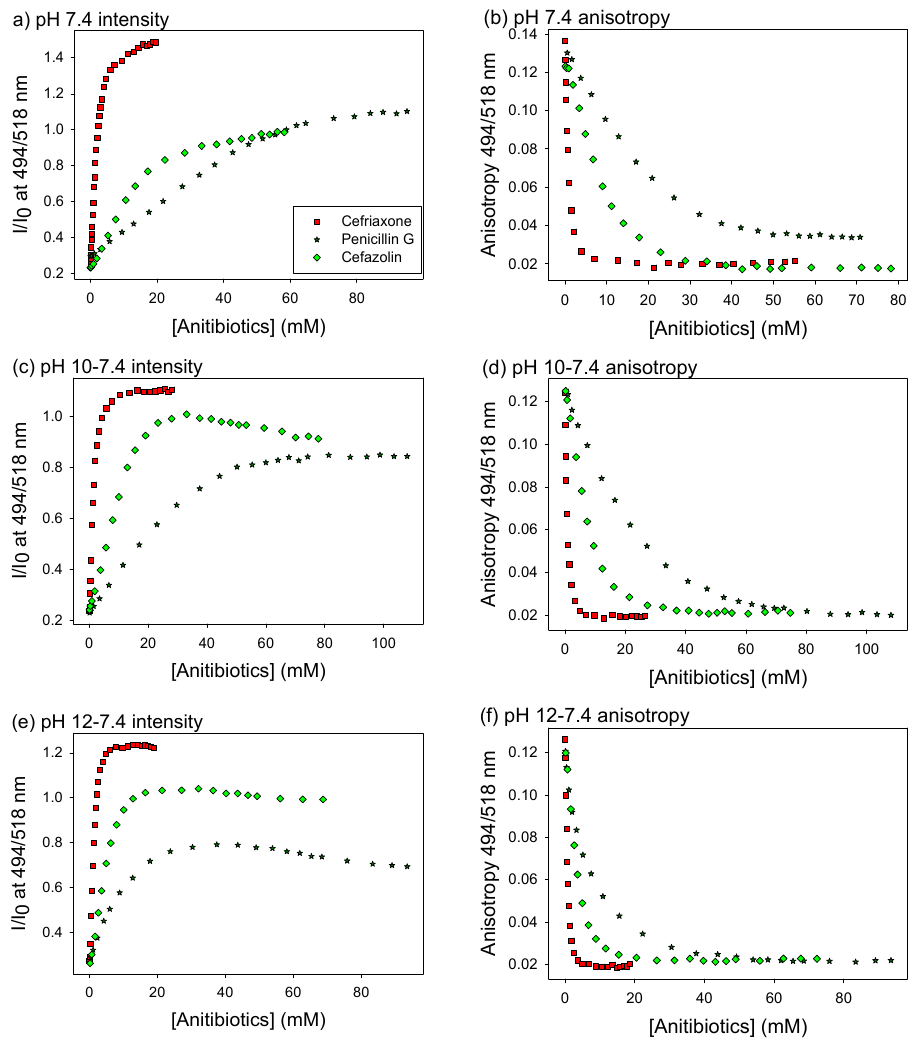
Figure 4. Fluorescence emission profiles from titrations of penicillin G, ceftriaxone, and cefazolin into [calcein • PAMAM] complex in solution. ( a , b ) Solutions prepared at pH 7.4; ( c , d ) solutions prepared at pH 10 and brought back to 7.4; ( e , f ) solutions prepared at pH 12 and brought back to 7.4. Left: fluorescence emission; right: fluorescence anisotropy. [calcein] = 6.36 µ M, [PAMAM G5] = 2.13 µ M, excitation: 494 nm, emission: 518 nm. Performed in 50 mM aqueous HEPES buffer at pH 7.4, T = 25 °C.